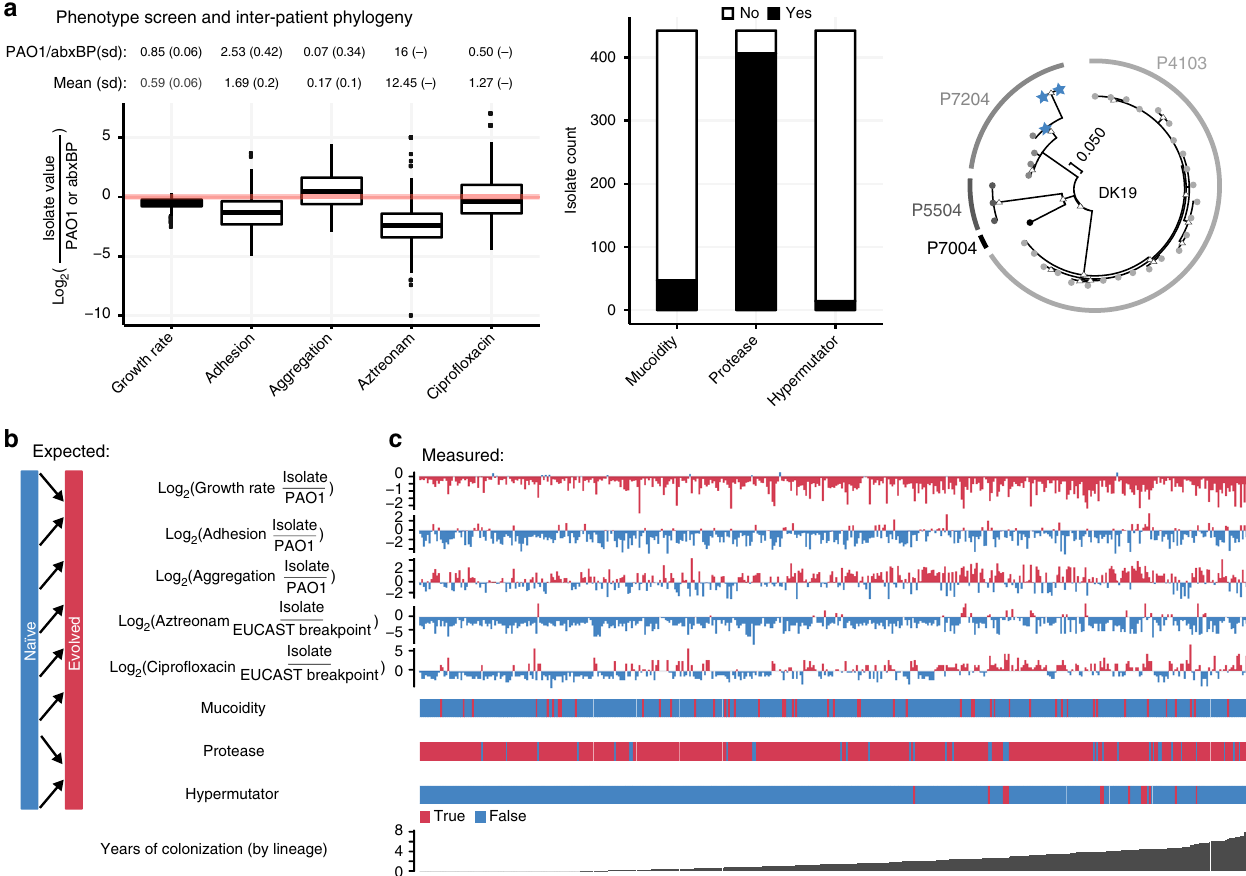
Fig. 2 Phenotypic characterization. We present summary statistics of our phenotype screen including a mean and mean standard deviation for each phenotype over all isolates as well as the P. aeruginosa PAO1 value and antibiotic breakpoint we use for normalization, respectively (above boxplot). We also show boxplots of continuous normalized variables (including the median as the center line, fi rst and third quartile box bounds and whiskers representing 1.5× inter-quartile range). We also show the overall count of isolates with presence/absence of mucoidity, protease and hypermutator phenotypes and a maximum likelihood phylogeny (1000 bootstraps) of the DK19 clone type; nodes marked with white triangles have bootstrap values > = 50. Blue stars represent late (>3 years) phenotypically naive (7 – 8 naive phenotypes out of 8) isolates from patient P7204. Circles with different shades of grey represent isolates from patients marked on the outer edge of the circle. We then compare the b expected adaptation over time based on fi eld consensus versus c the measured raw adaptation of our isolate collection over time. The X-axis represents the time since colonization of a speci fi c lineage or “ colonization time ” . Colors are linked with the expected change of the speci fi c phenotype ( b ), so that blue denotes a “ naive ” phenotype and red denotes an “ evolved ” phenotype. For growth rate (in arti fi cial sputum medium (ASM)), adhesion and aggregation, naive and evolved phenotypes are determined by comparison with the reference isolate PAO1 phenotype. For aztreonam and cipro fl oxacin MIC, naive and evolved phenotypes are based on sensitivity or resistance as indicated by the EUCAST breakpoint values as of March